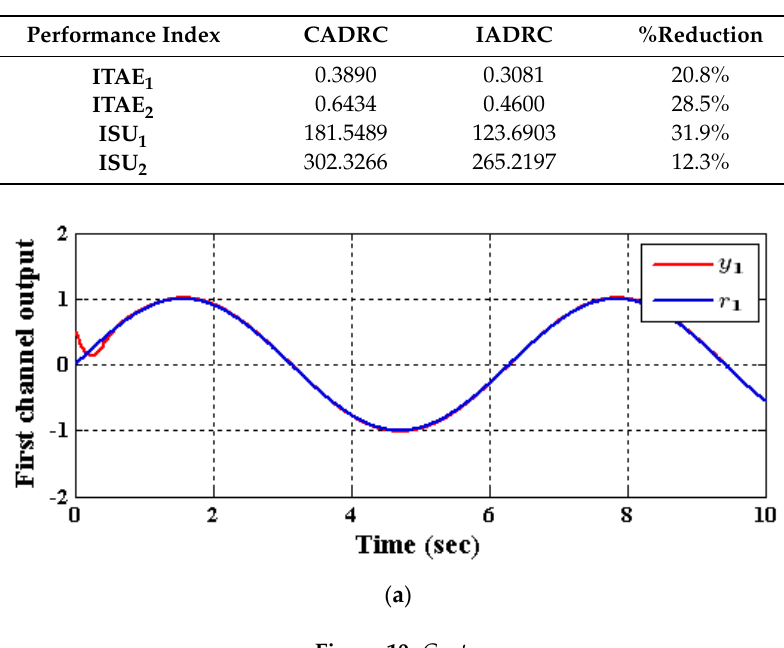
Table 6. Performance of the decentralized ADRC scheme.